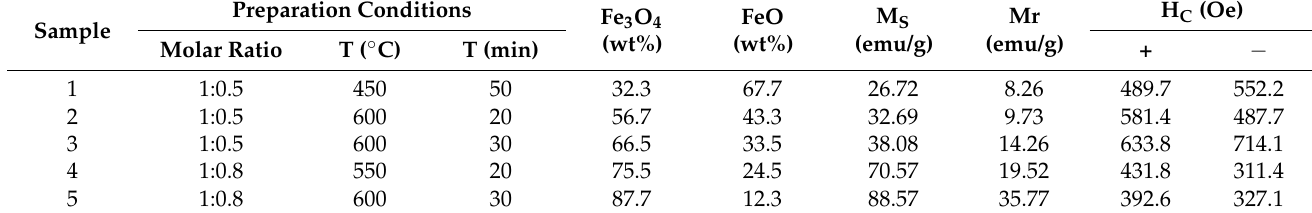
Table 1. Magnetic Properties of Fe 3 O 4 /FeO Samples.